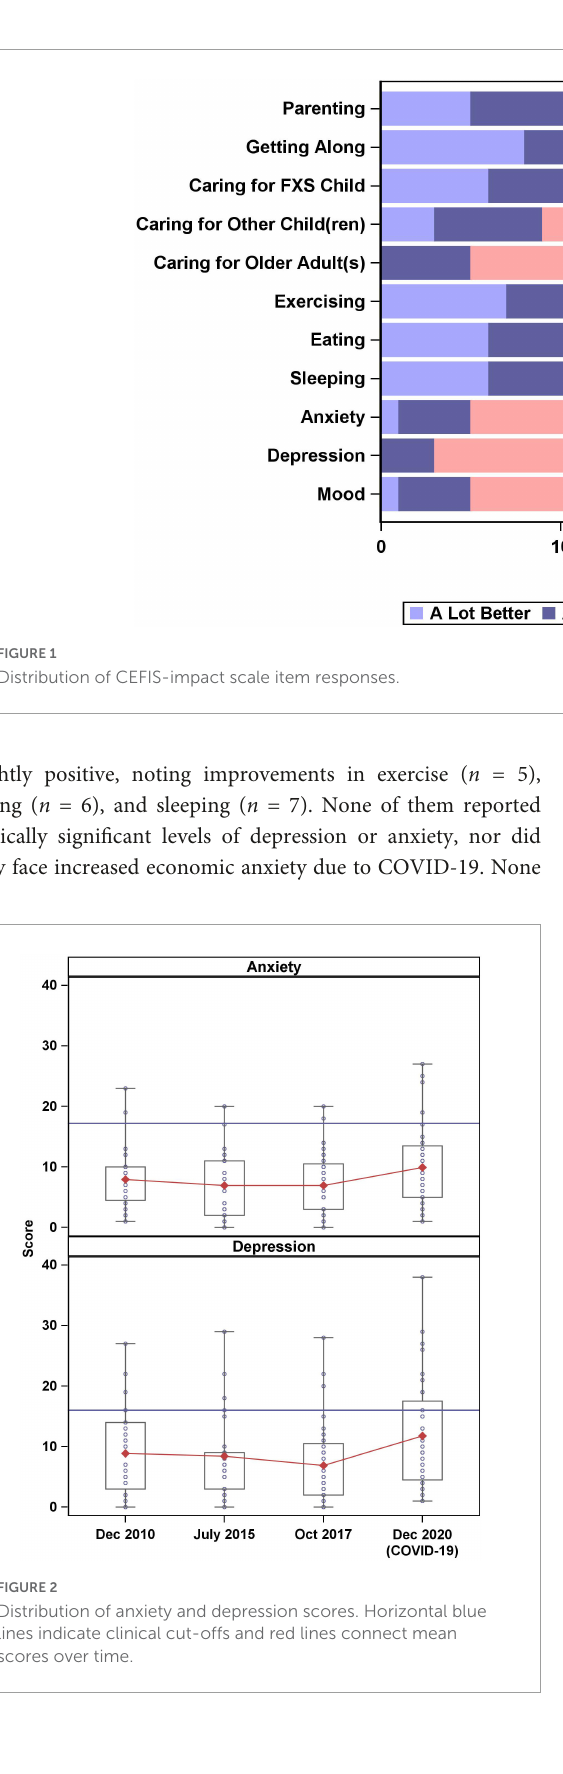
FIGURE2 Distribution of anxiety and depression scores. Horizontal blue lines indicate clinical cut-offs and red lines connect mean scores over